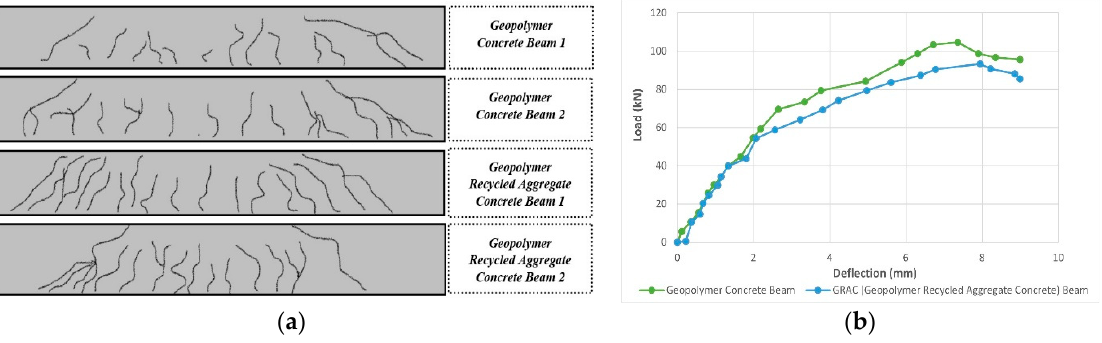
Figure 8. ( a ): The crack pattern of geopolymer concrete beams and GRAC beams; and ( b ) the load- deflection curves of geopolymer concrete beams and GRAC beams [48]